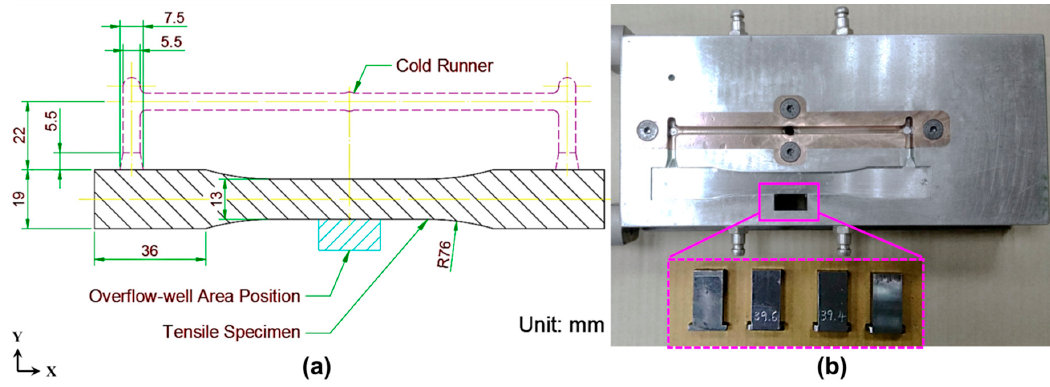
Figure 1. Schematic of tensile specimens: ( a ) diagram of the mold cavity of specimens; and ( b ) configuration of overflow-well area and insert.